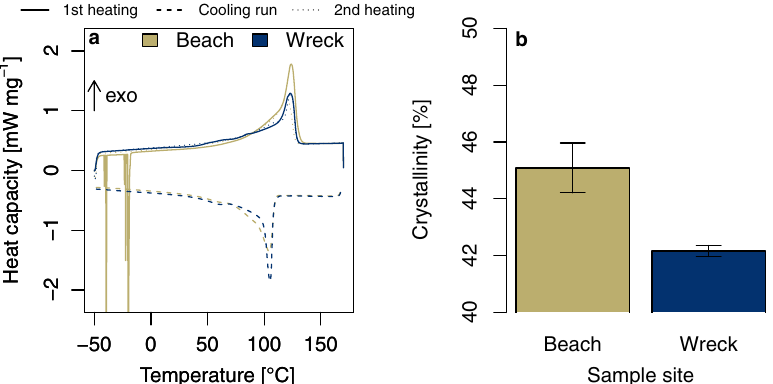
Figure 5. Thermal DSC analysis of MP resin pellets from a beach in the Wadi el Gemal national park, Egypt, and the SS Hamada wreck in the Red Sea. ( a ) Average of ten DSC curves for each sample site. The higher the melting peak in the heating runs, the higher the degree of crystallization. ( b ) Crystallinity of beached MP was higher than for pellets from the wreck. Values are given as mean ± s.e.m. for n = 10 replicates.